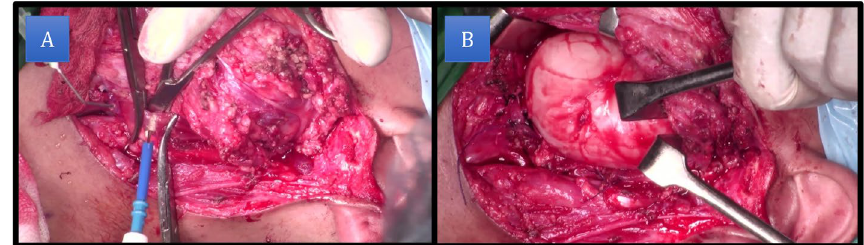
Fig. 5 A Posterior belly of digastric being divided, and B tumor exposed and seen separate from the deep lobe of the parotid gland, suggestive of a de-novo pleomorphic adenoma